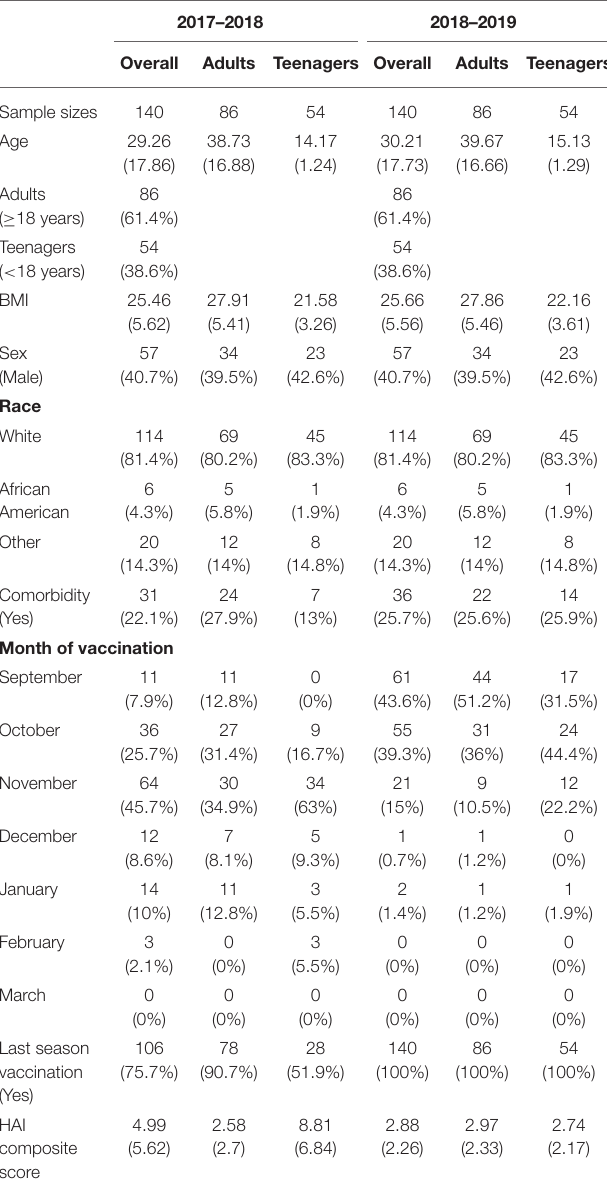
Standard deviations/percentages in parentheses for continuous/categorical